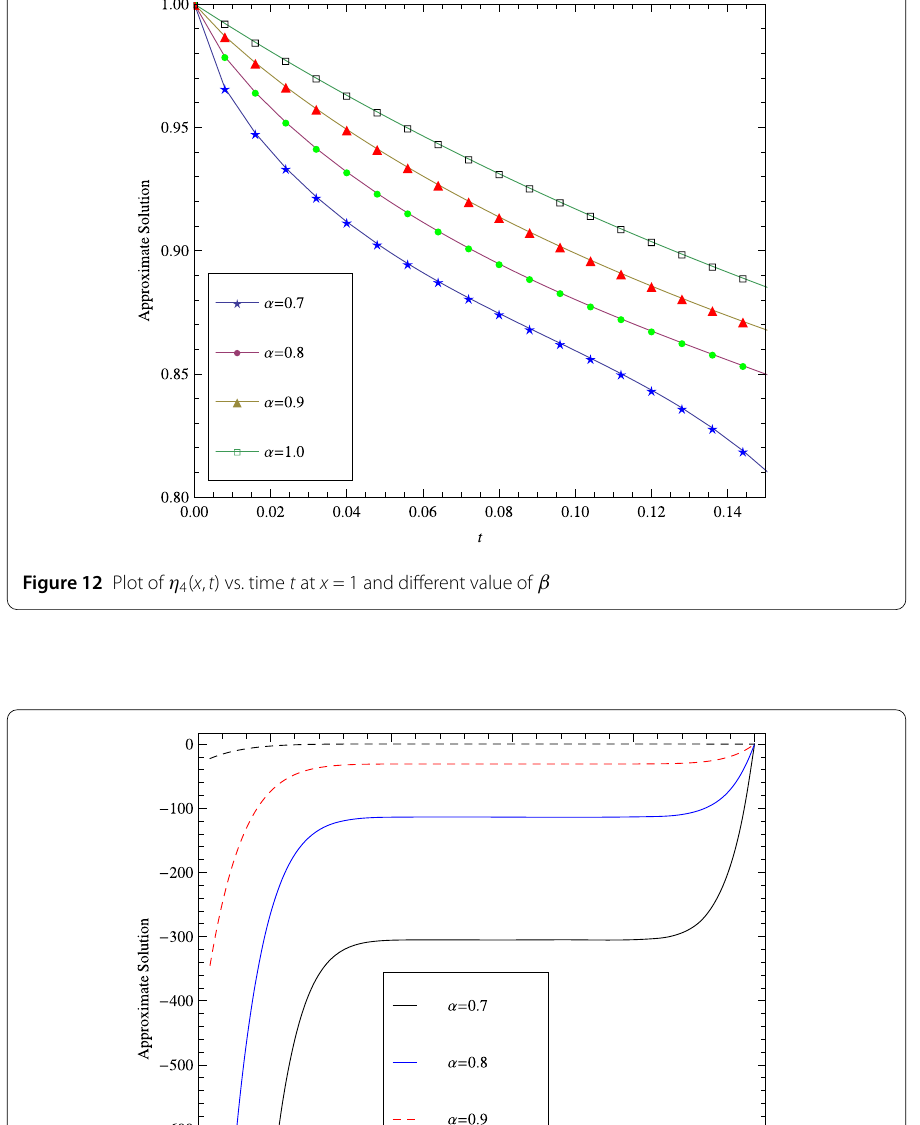
Figure 13 Plot of (cid:2) -curve for different values of β